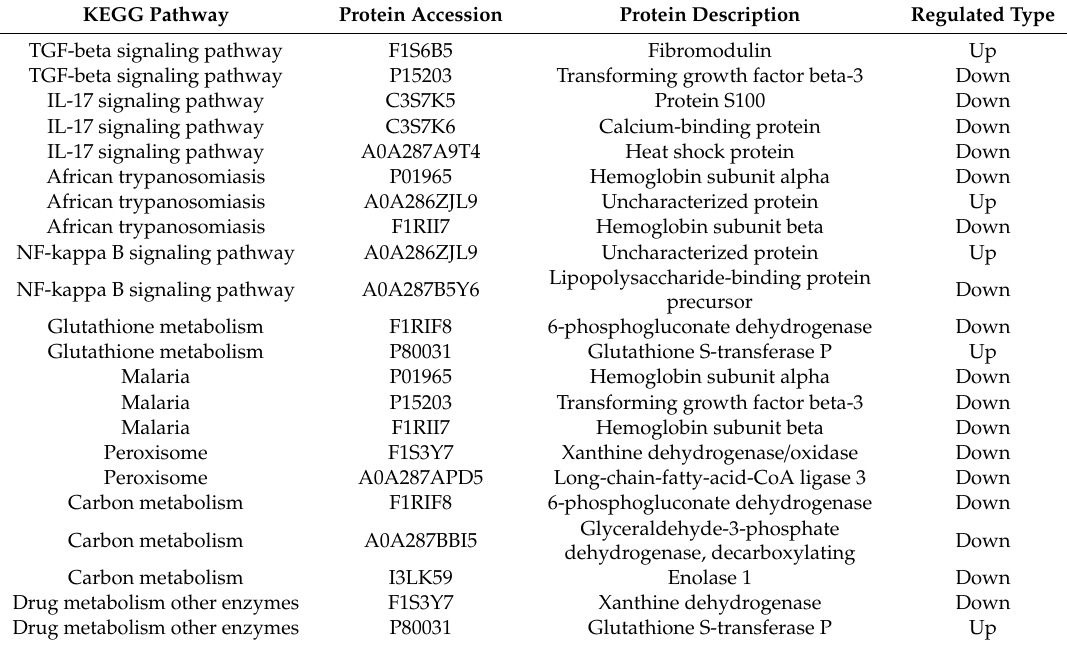
Table 3. KEGG pathway enrichment of PC vs. CC di ff erential proteins. Note: PPAR, peroxisome proliferator-activated